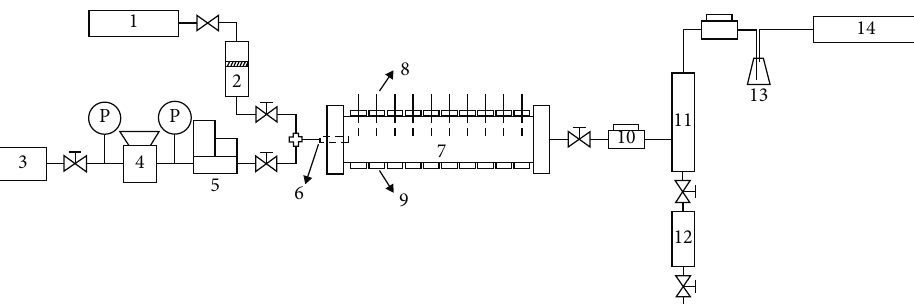
Figure 1: Schematic diagram of the combustion tube experimental platform. 1: constant- fl ux pump; 2: piston container; 3: air source; 4: pressure regulating valve; 5: gas mass fl owmeter; 6: igniter; 7: combustion tube; 8: temperature sensor; 9: heating tile; 10: back pressure; 11: fi rst separator; 12: second separator; 13: gas drying bottle; 14: gas component detector.